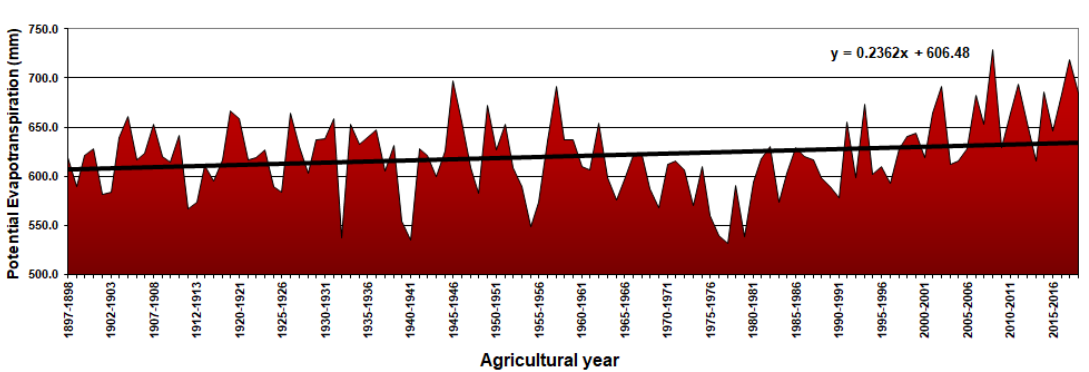
Figure 13. Potential evapotranspiration in the hot season calculated for the Banat Plain between 1897-2019. Figure 13.